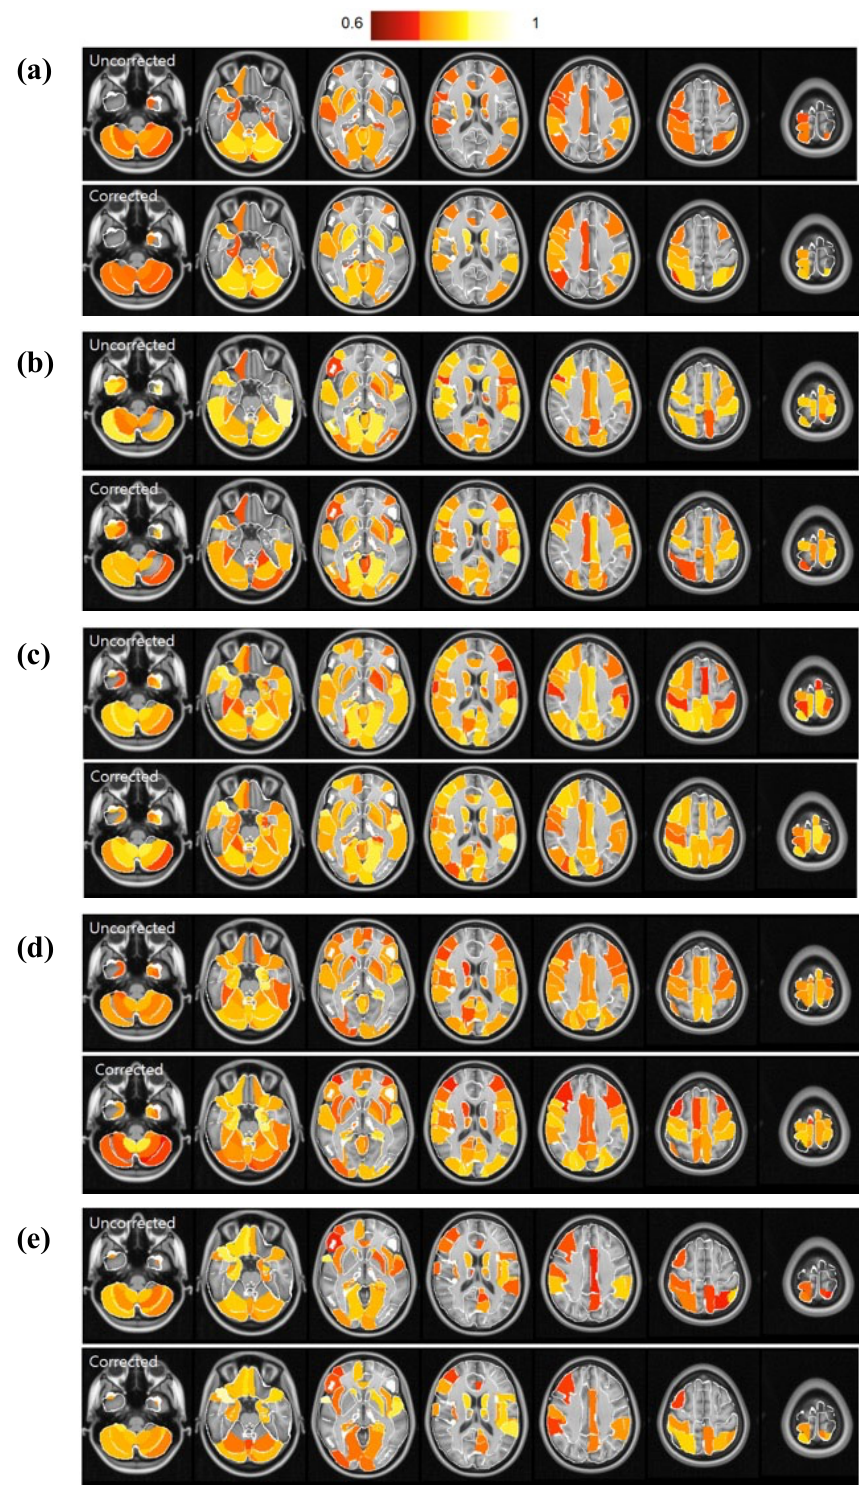
Figure 1. Maps of ICC values at representative ROIs based on AAL3, before and after the correction. ( a ) Functional connectivity (FC), ( b ) fractional amplitude of low-frequency fluctuation (fALFF), ( c ) regional homogeneity (ReHo), ( d ) voxel-mirrored homotopic connectivity (VMHC), and ( e ) degree centrality (DC).